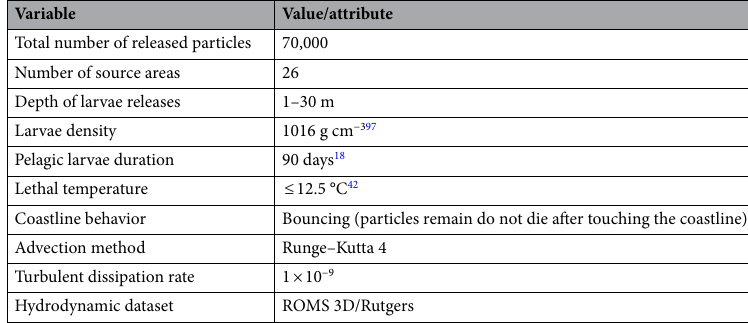
Table 1. Configuration of the biophysical parameters used to feed the Ichthyop simulations.